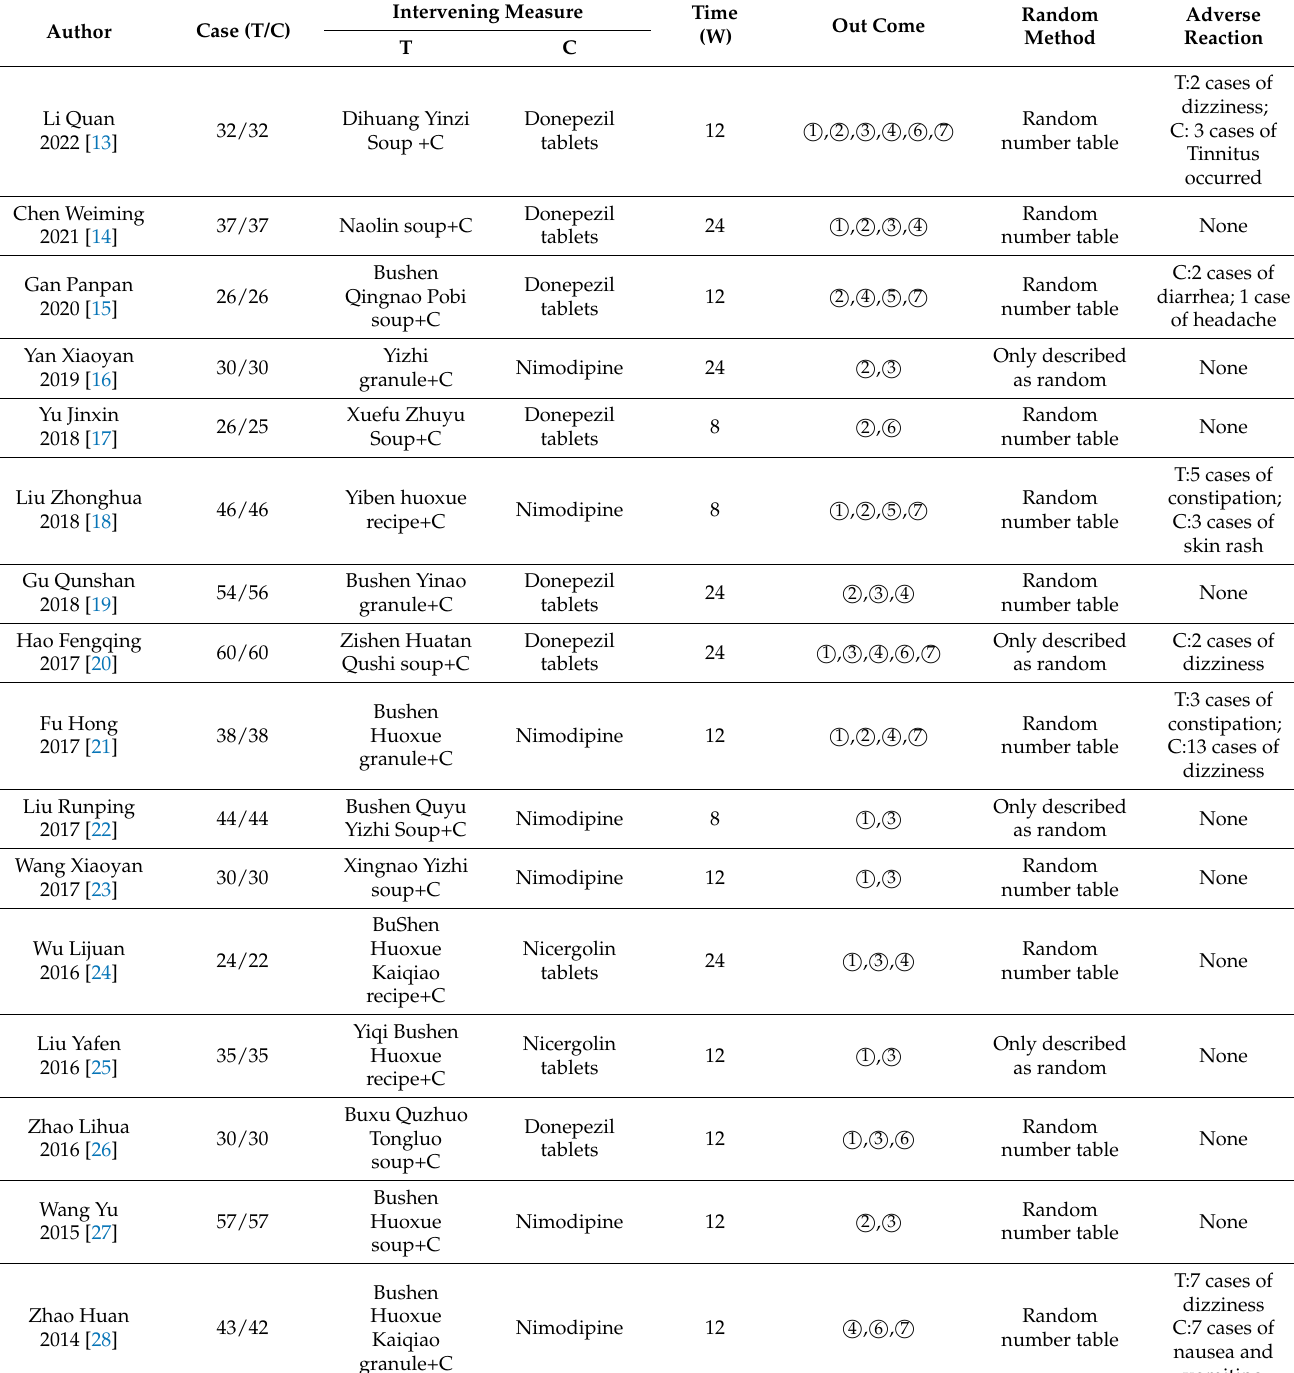
Table 1. Basic characteristics of the included